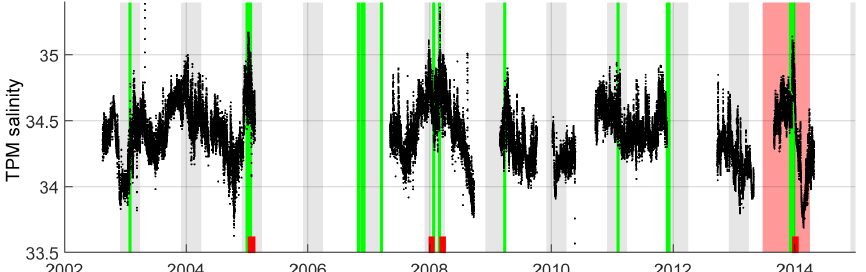
Figure 2. Salinity at the Tiree Passage Mooring at 20m. Grey bars denote winter months (DJFM). Green lines show instances of daily mean westerly winds on Malin Shelf exceeding 18m s − 1 after Jones et al. (2018); there are 17 occurrences between 2002 and 2015. Red ticks indicate high-salinity pulses (HSPs). The pink bar highlights the drifter study period (shown again in Fig.